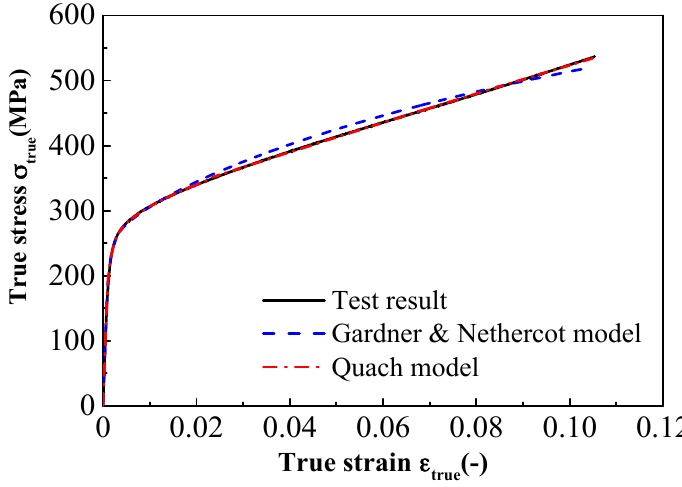
Figure 9. Comparison between the test and two fitting stress-strain curves.